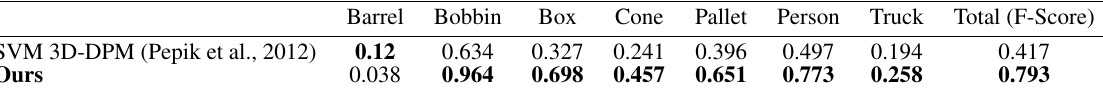
Table 3. Results of the object detection on the synthetic dataset using the proposed framework